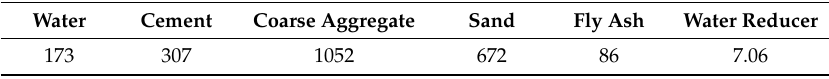
Table 1. Mix proportion of fresh concrete (kg/m 3 ).